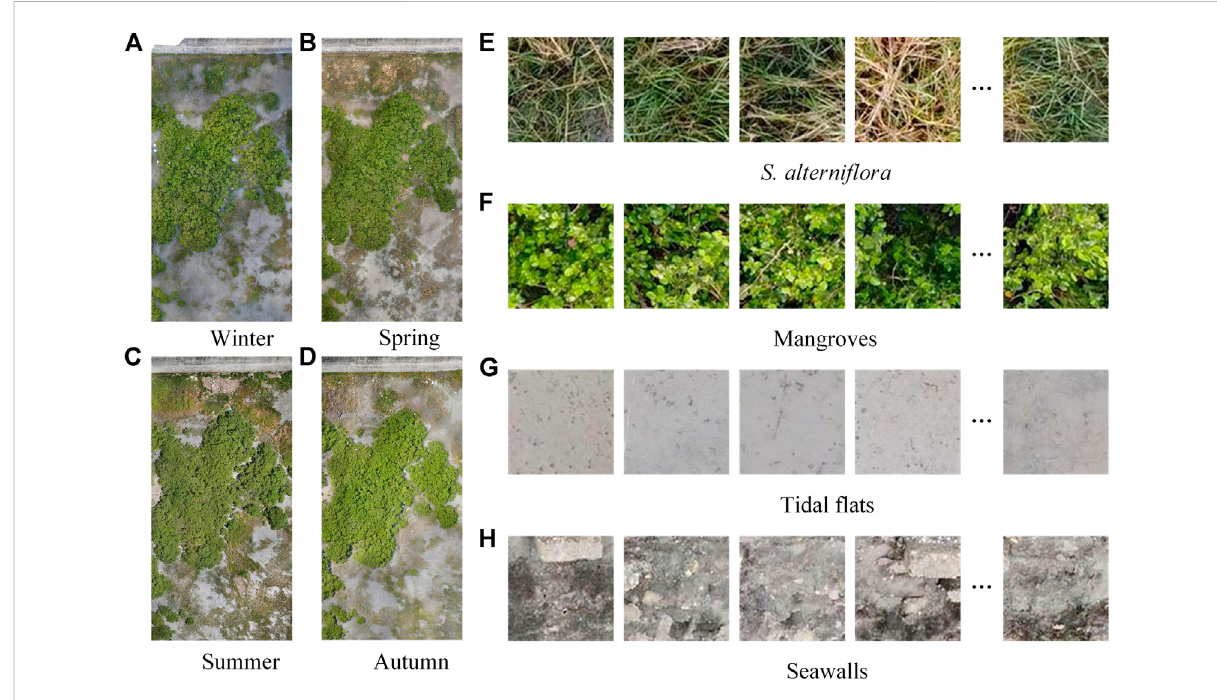
FIGURE 2 Orthophotos and dataset categories. Where (A – D) are orthophotos in winter, spring, summer, and autumn (2020/12, 2021/03, 2021/06, 2021/ 09); (E – H) are schematic diagrams of S. alterni fl ora , mangroves, tidal fl ats, and seawalls.